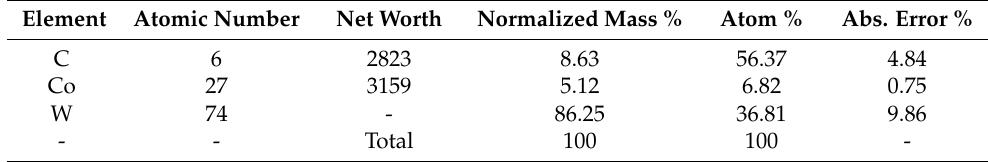
Figure 12. EDS analysis of the WC-12Co coating surface. Table 7. EDS analysis of the WC-12Co coating surface.